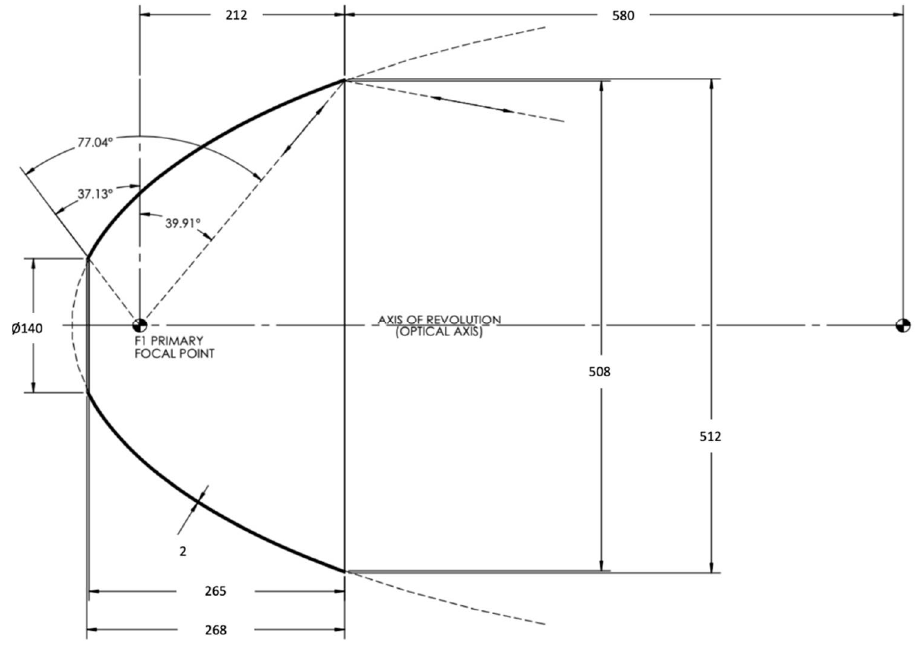
Figure 4. Main geometrical data of Optiforms elliptical reflectors mod. E1585-0100 (dimensions in mm).